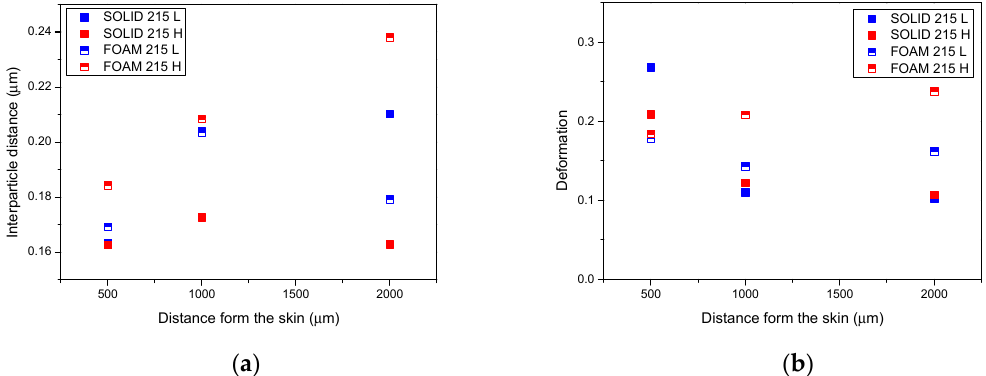
Figure 4. ( a ) Interparticle distance and ( b ) deformation for 215 low (L) and 215 high (H) foamed and solid samples.